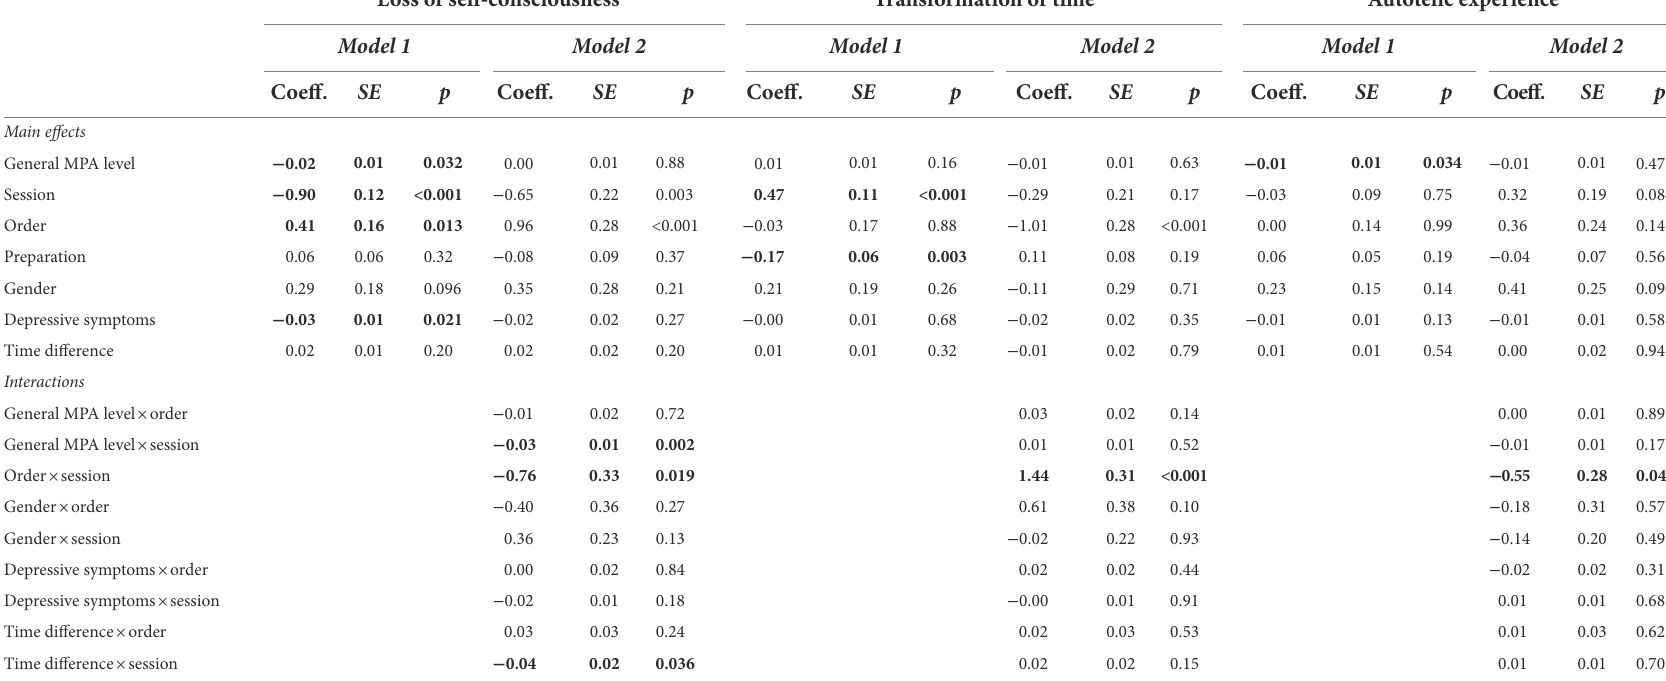
TABLE 5 Estimated linear mixed models for the dimensions “loss of self-consciousness,” “transformation of time,” and “autotelic